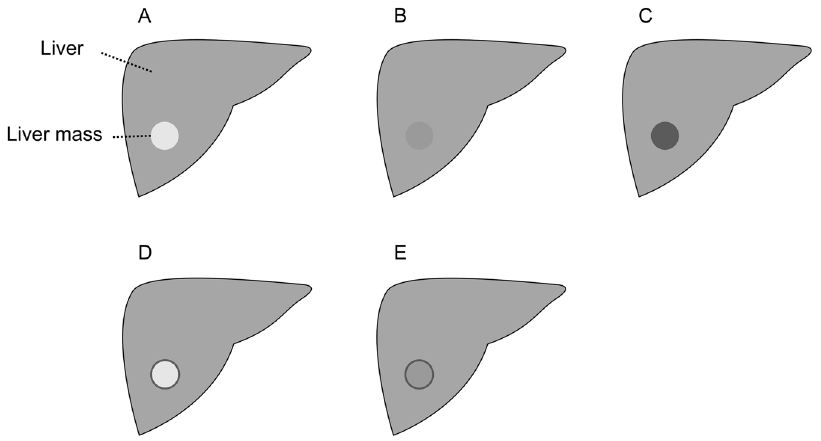
Figure 1. Different echo pattern of homogenous liver masses in ultrasound B-mode presented in a schematic overview. Relative to the liver echopattern, liver masses can appear hyperechoic (brighter) ( A ), isoechoic (similar) ( B ) or hypoechoic (darker) ( C ). Iso- and hyperechoic liver masses can present with a hypoechoic halo (rim) ( D,E ). Note: figure adapted from 26